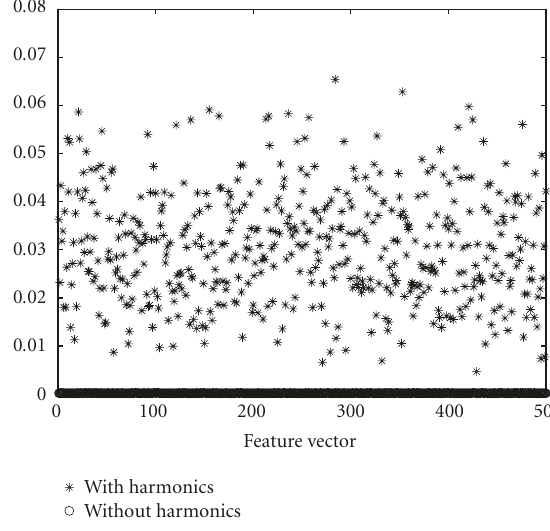
Figure 21: HOS-based features extracted from h α = (cid:9) c 2, h